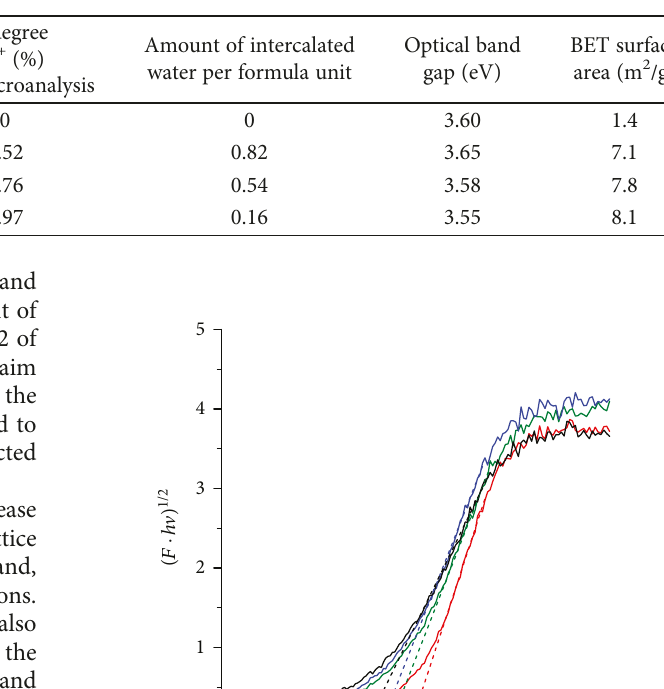
Table 1: Characteristics of obtained Rb X-ray microanalysis, intercalated water content, and BET surface area.